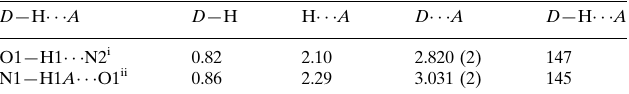
Hydrogen-bond geometry (A˚ , (cid:2)